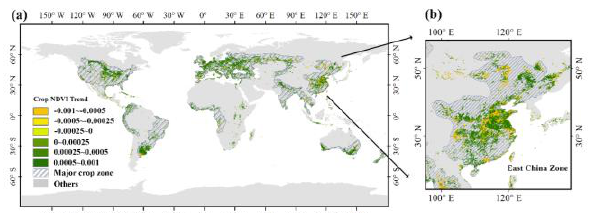
Figure 1. Global crop maximum NDVI trend during the entire study period (1982-2012). (a) is the spatial distribution of global crop NDVI trend, and (b) is the corresponding